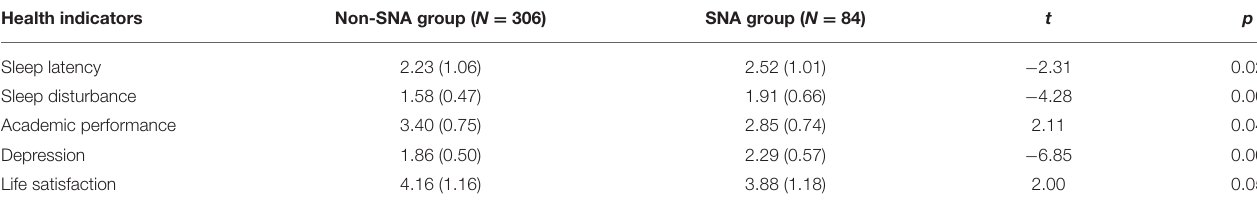
TABLE 4 | Independent samples t -tests comparing health indicators between SNA and non-SNA groups based on 1,000 bootstrap samples.